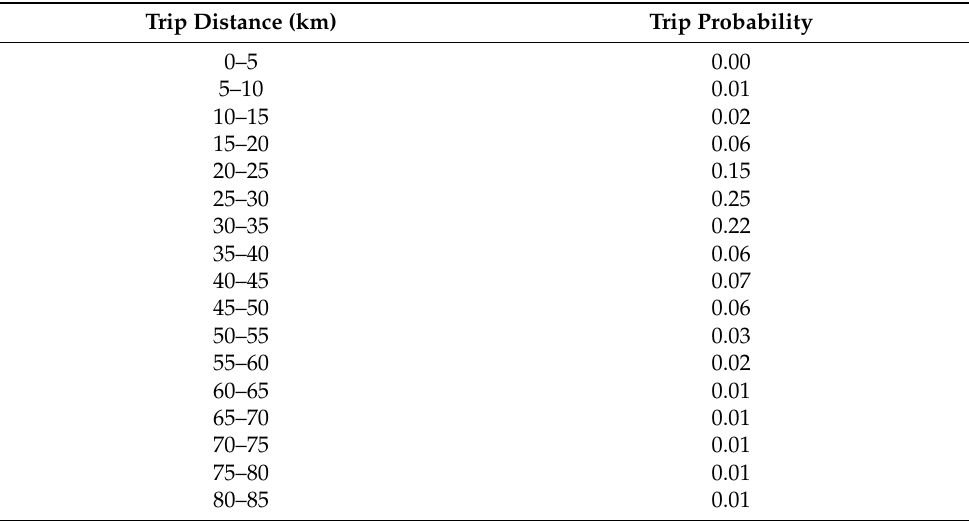
Table 5. Trip distance probability distribution.